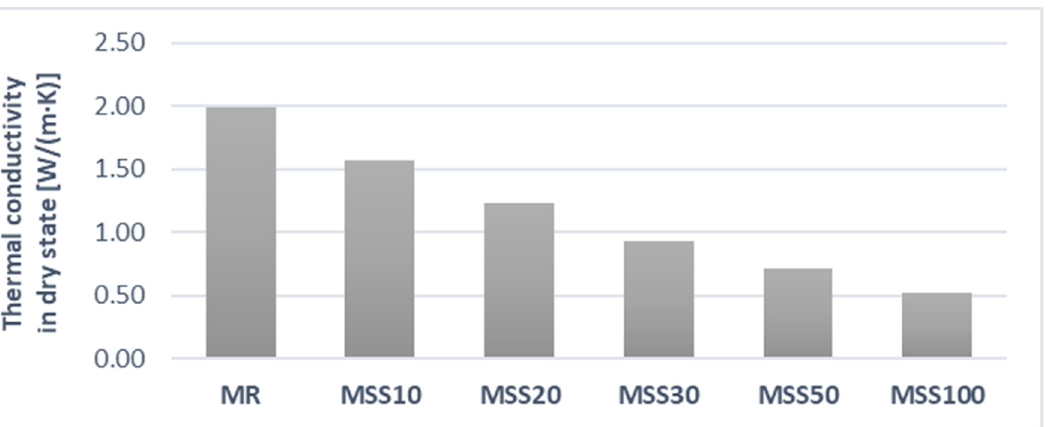
Figure 12. Compressive strength of mortars after 7, 28, and 56 days of maturation.